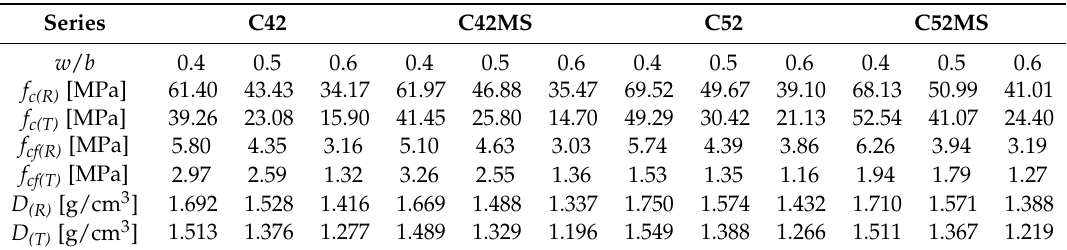
Table 2. The results of the mechanical and physical characteristics of the tested cement pastes.